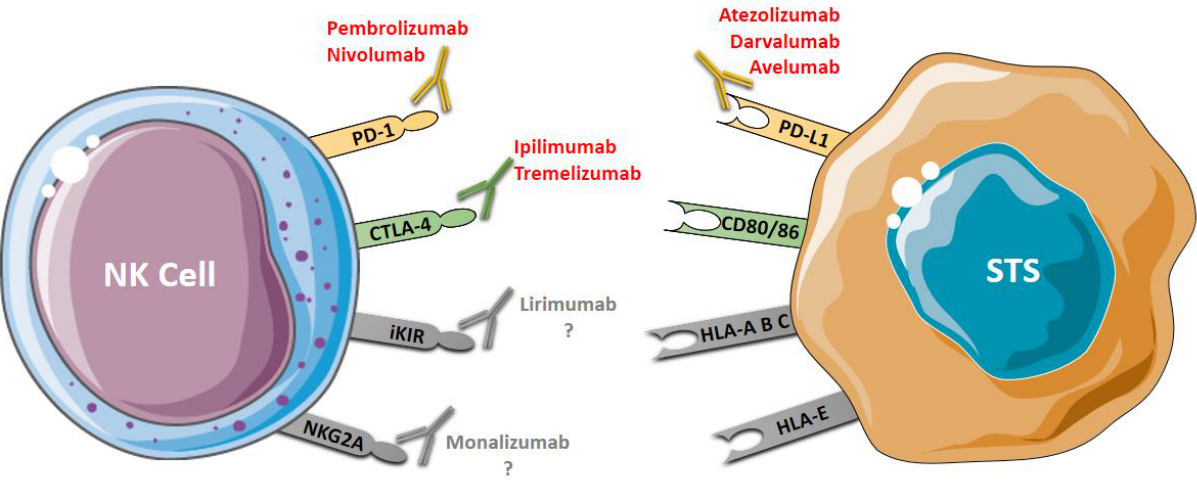
Figure 2. Antibody-based immunotherapy in STS. PD-1 and CTLA-4 are co-inhibitor receptors expressed by NK that can be blocked using immune checkpoint inhibitors: anti-PD-1 (pembrolizumab and nivolumab) and anti-CTLA-4 (ipilimumab and tremelizumab). PD-L1, a ligand of PD-1 expressed by tumor cells, can be blocked using anti-PD-L1 (avelumab, darvalumab e atezolizumab). iKIR and NKG2A, two specific NK inhibitory receptors, can be blocked by anti-KIR (lirimumab) and anti-NKG2A (monalizumab); however, there are no studies on the use of these drugs (lirimumab e monalizumab) in STS. Blocking these receptors restores the cytotoxic activity of the NK cells.